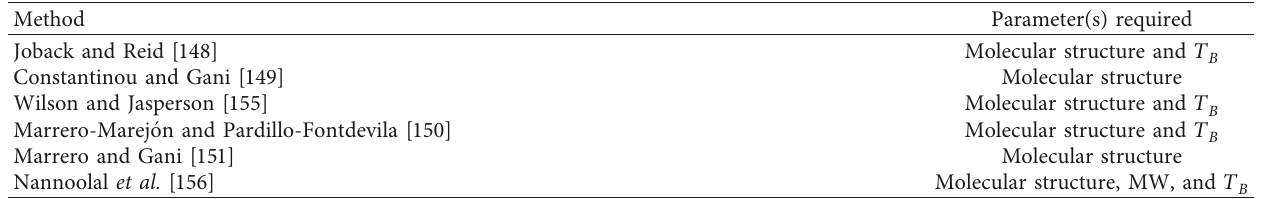
Table 11: Methods for the critical parameters’